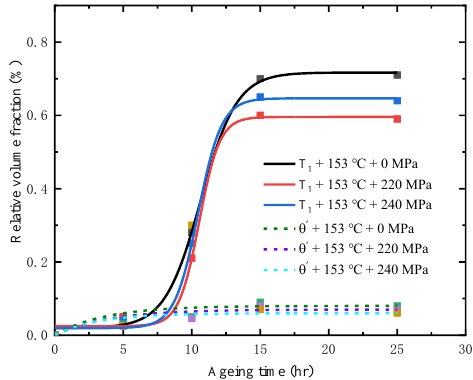
Figure 8. The relative volume fraction curves of T 1 phase and phase of Al-Li-S4 aluminum alloy under different stress creep aging conditions.